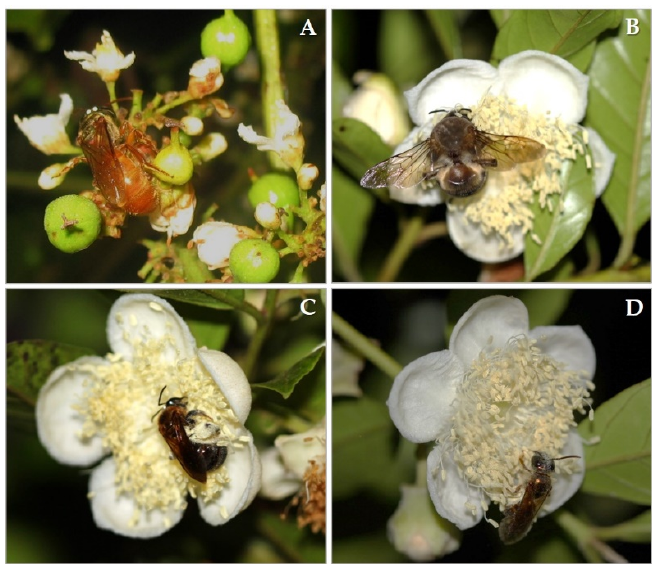
Figure 1. Nocturnal bees: ( A ) Megalopta aeneicollis, ( B ) Ptiloglossa latecalcarata, ( C ) Megommation insigne, ( D ) Megalopta